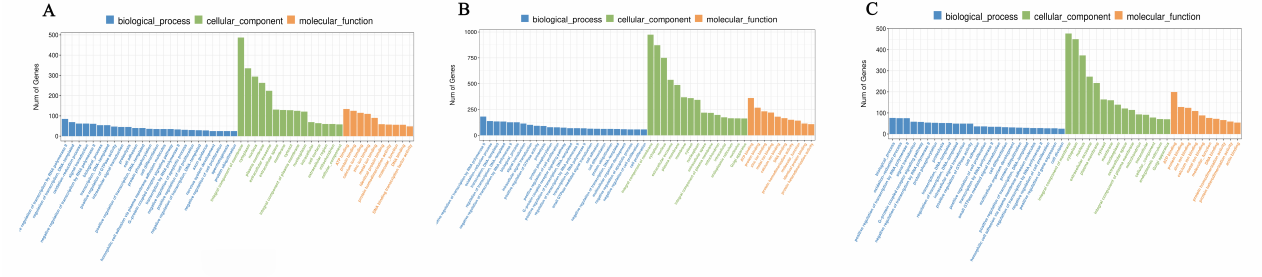
Figure 8. GO enrichment analysis of differentially expressed genes (DEGs) in breast muscle.